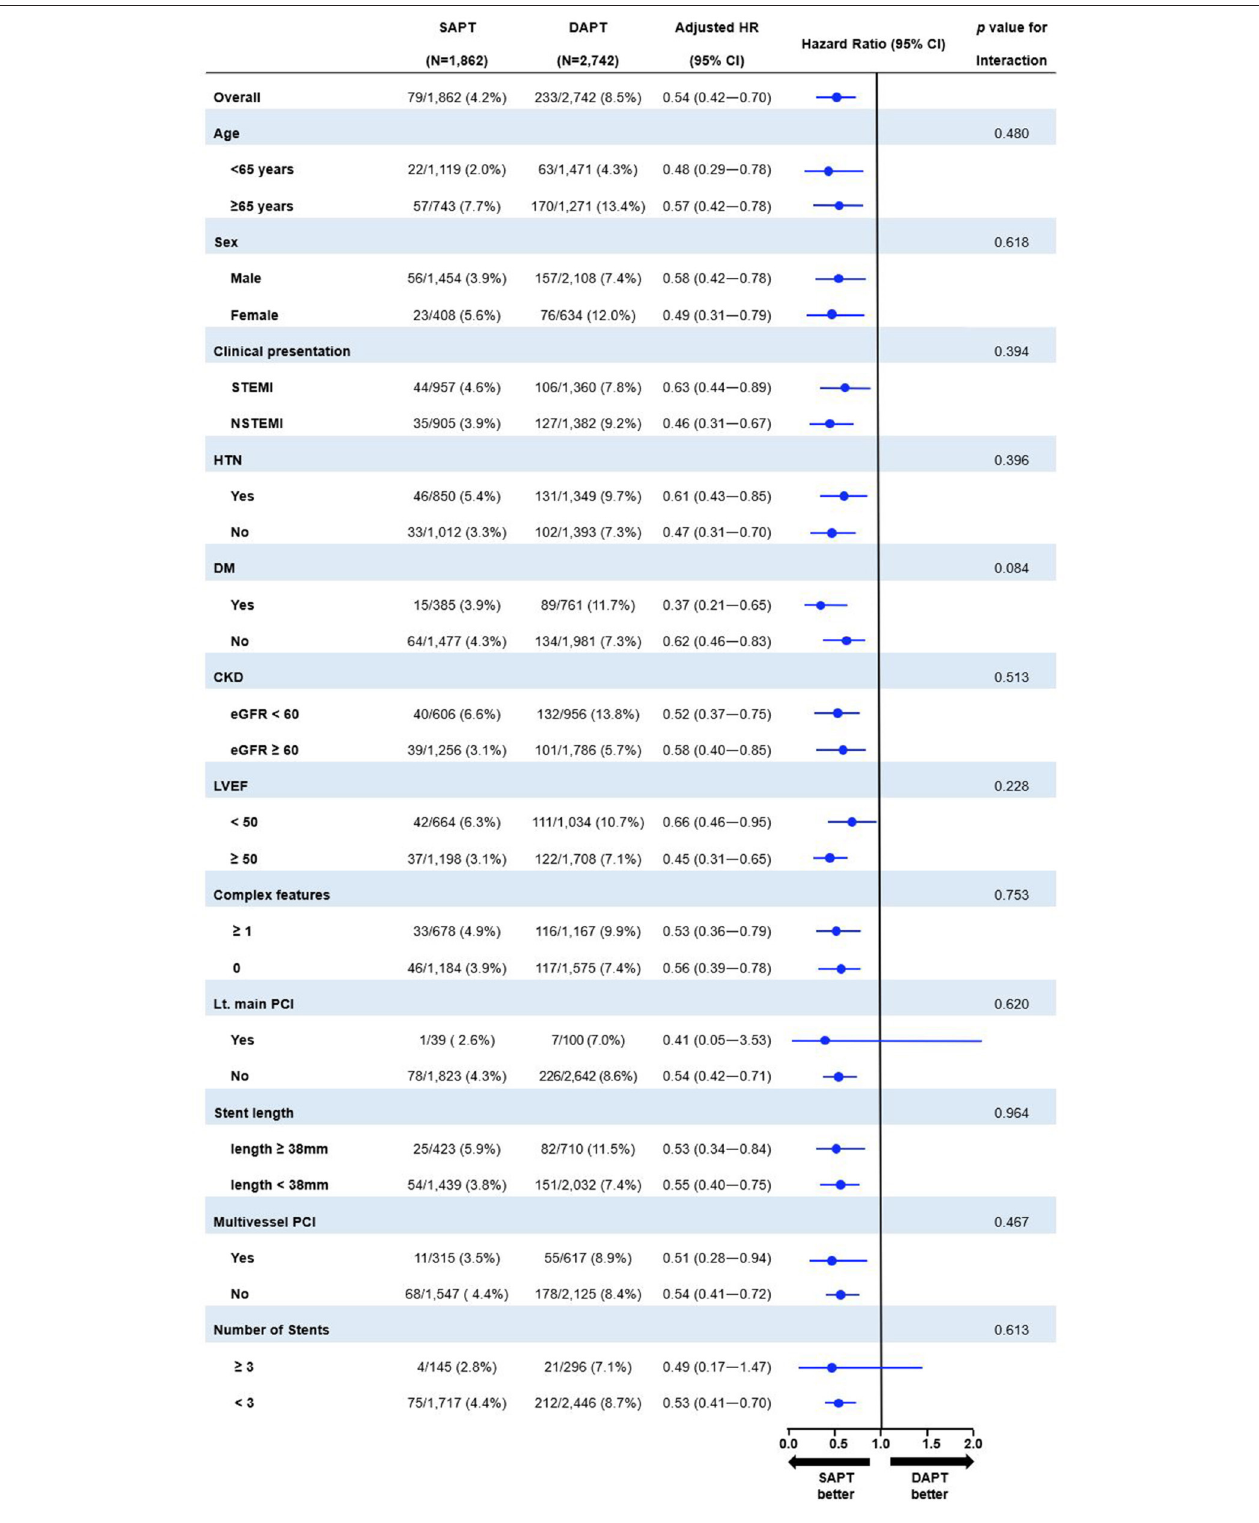
FIGURE 5 | Exploratory subgroup analysis of MACCE between 12 and 36 months according to antiplatelet strategy. SAPT, single antiplatelet therapy; DAPT, dual antiplatelet therapy; HR, hazard ratio; CI, confidence interval; STEMI, ST-elevation myocardial infarction; DM, diabetes mellitus; CKD, chronic kidney disease; eGFR, estimated glomerular filtration rate; LVEF, left ventricular ejection fraction; PCI, percutaneous coronary intervention.